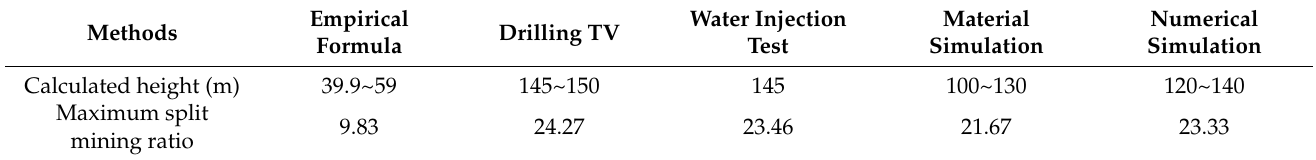
Table 3. Comparison of height of water conducting fissures water-conducting fracture